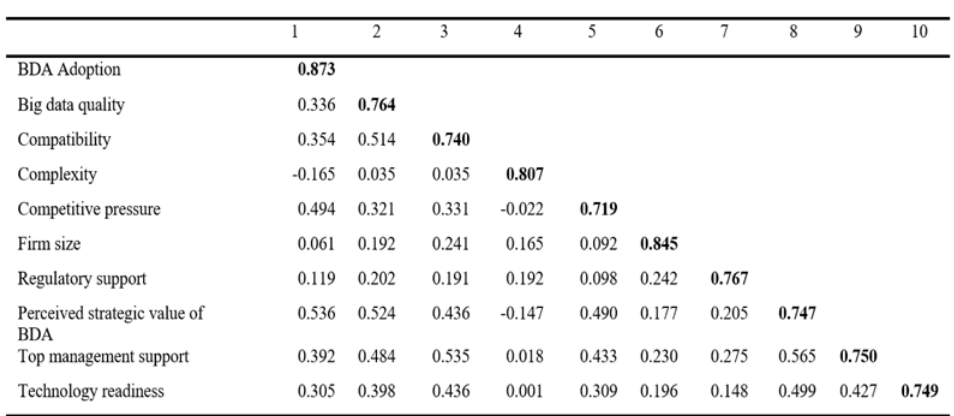
Correlations and